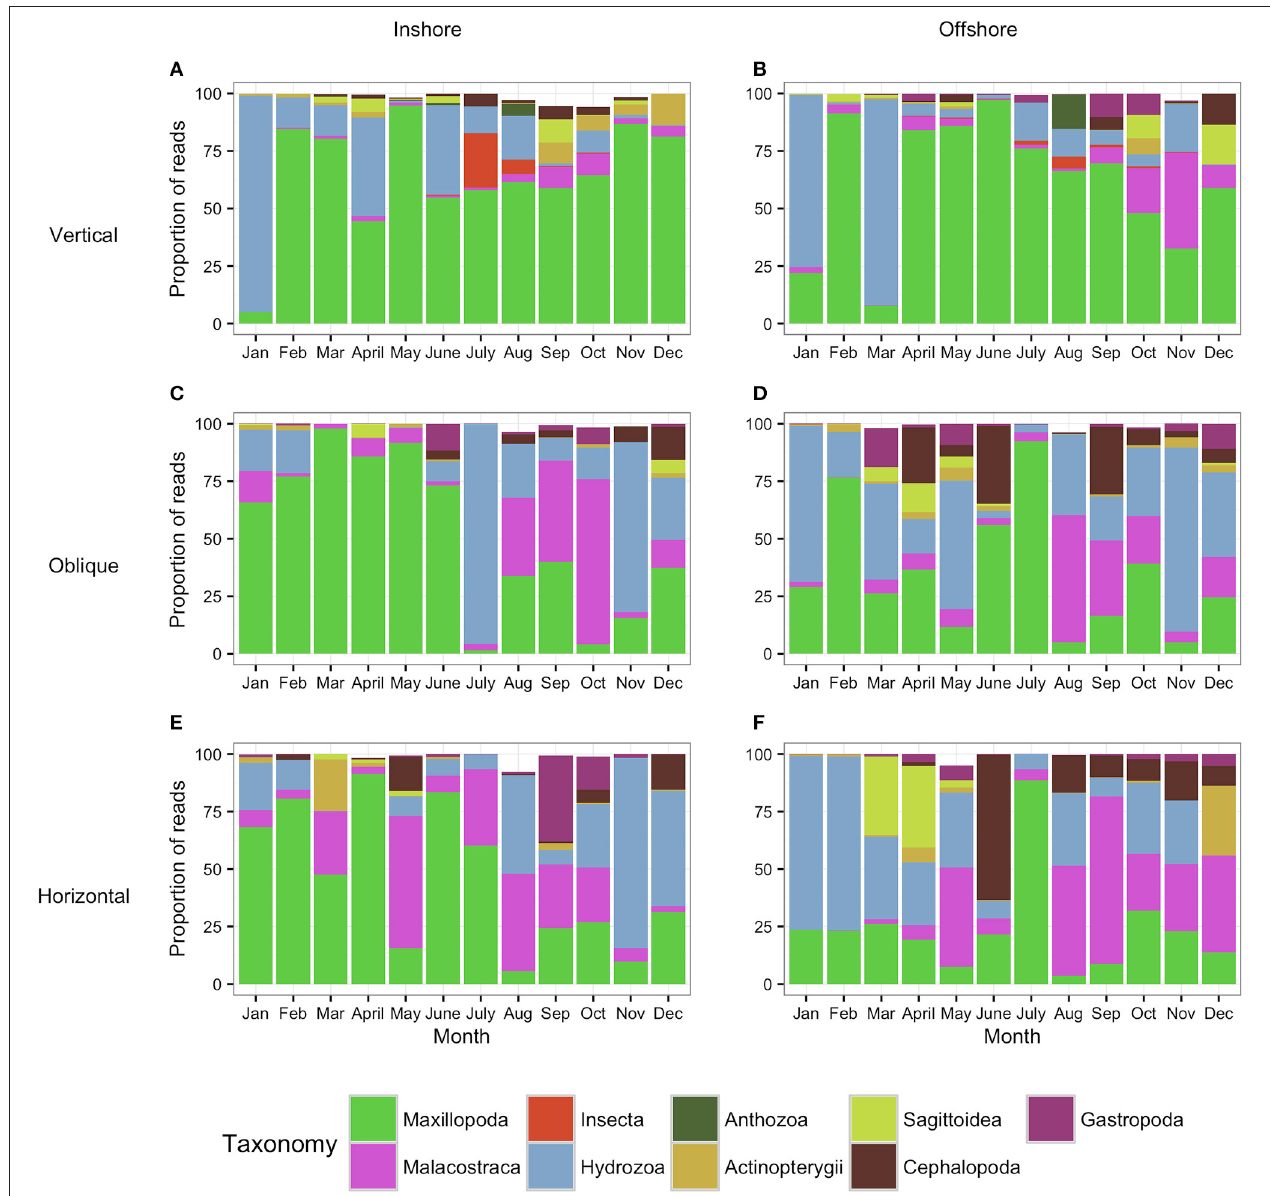
FIGURE 5 | Metazoan composition of the samples collected using the WP2 tows (Vertical: A,B ) and the bongo tows (Oblique: C,D ; Horizontal: E,F ). Proportion of reads produced by the WP2 and the bongo tows assigned to metazoan taxa showing the monthly trends for 1 year. (A,C,E) correspond to the inshore station while (B,D,F) correspond to the offshore station. Taxa which contributed to less than 0.5% of the community are not shown (thus proportion values do not always reach 100%).